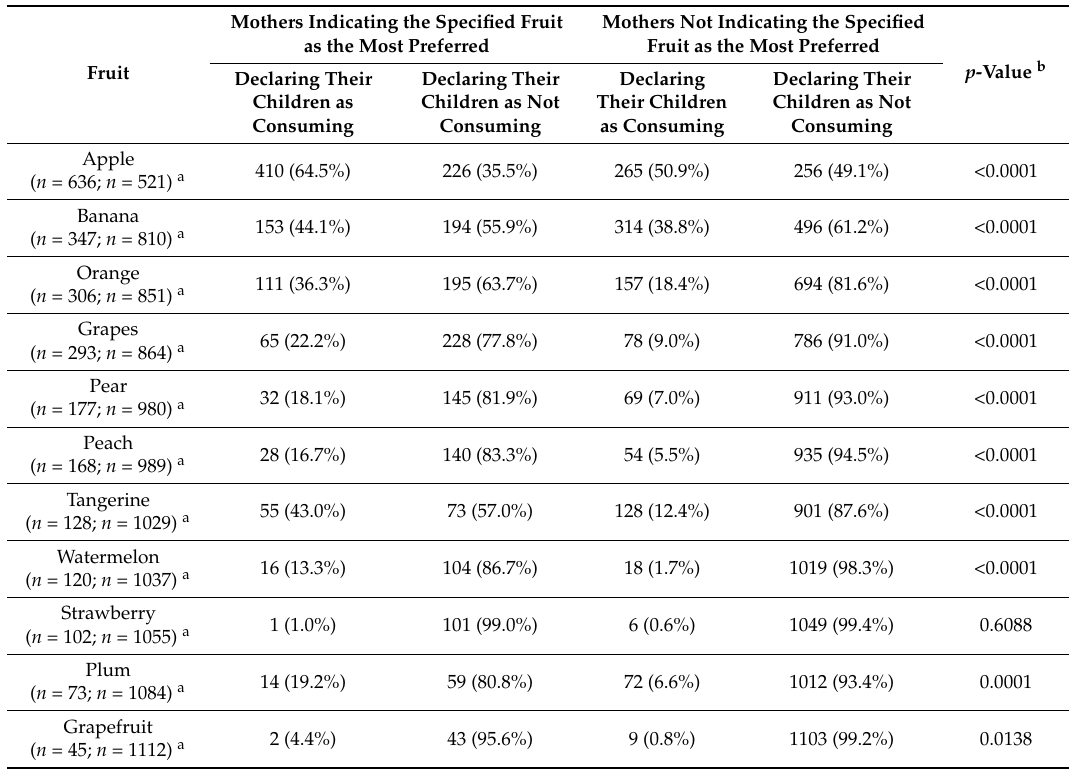
Table 6. Analysis of the association between the fruit preferences of mothers and their declared